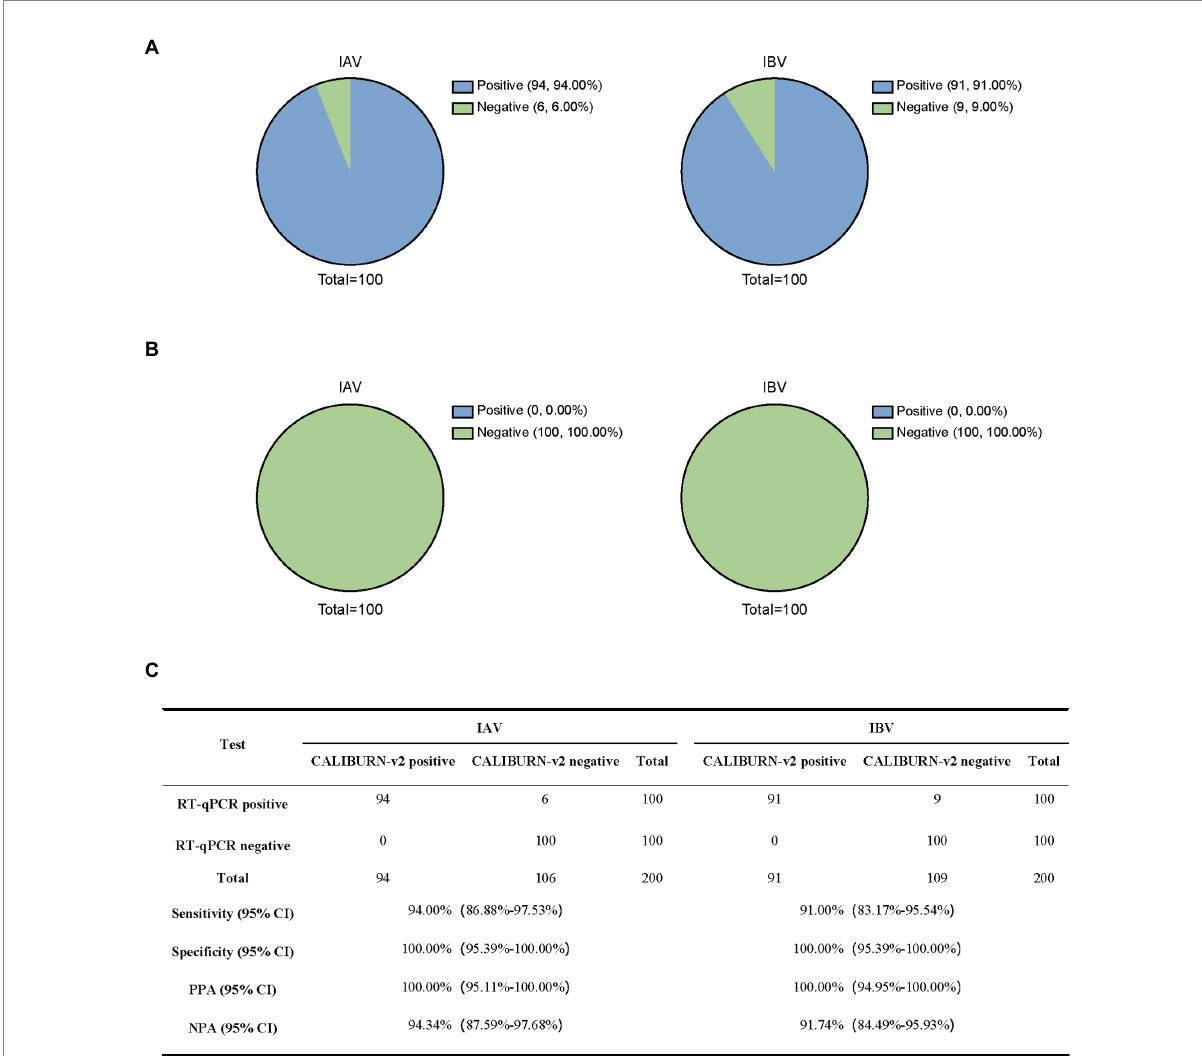
FIGURE 5 Detection of influenza virus using CALIBURN-v2. (A,B) Sensitivity (A) and specificity (B) of CALIBURN-v2 for influenza virus detection. (C) Concordance between RT-qPCR and CALIBURN-v2 for IAV and IBV. The RT-RPA primers and crRNAs for IAV and IBV are used to detect nucleic acid samples from healthy donors, respectively. PPA, positive predictive agreement; NPA, negative predictive agreement; CI, confidence interval.